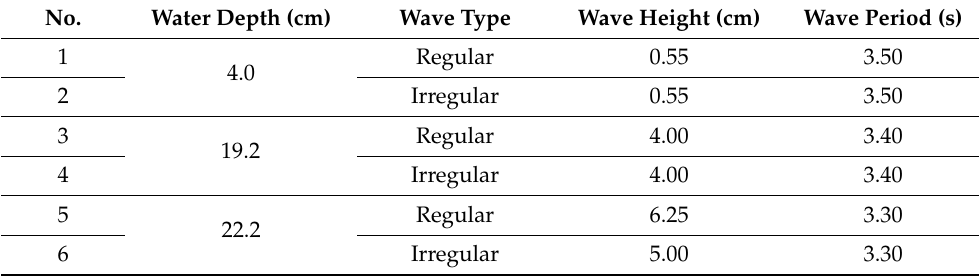
Table 1. Experimental environmental